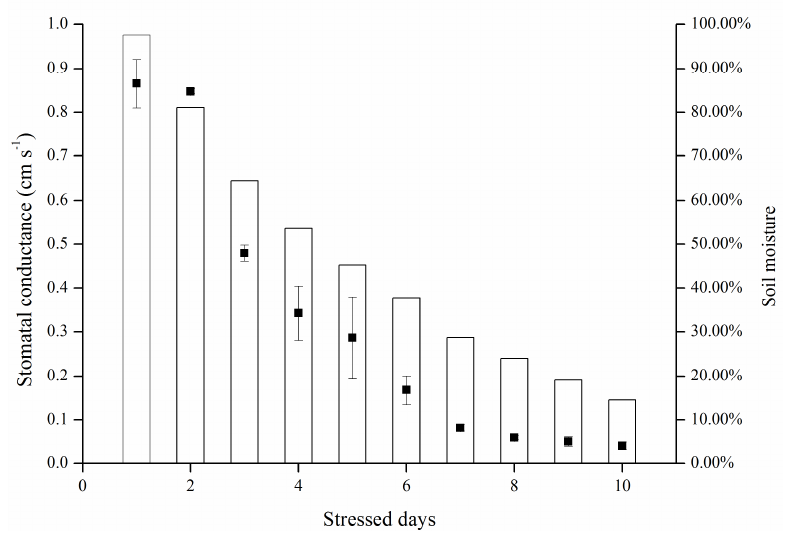
Figure 6. Leaf stomatal conductance variance during water